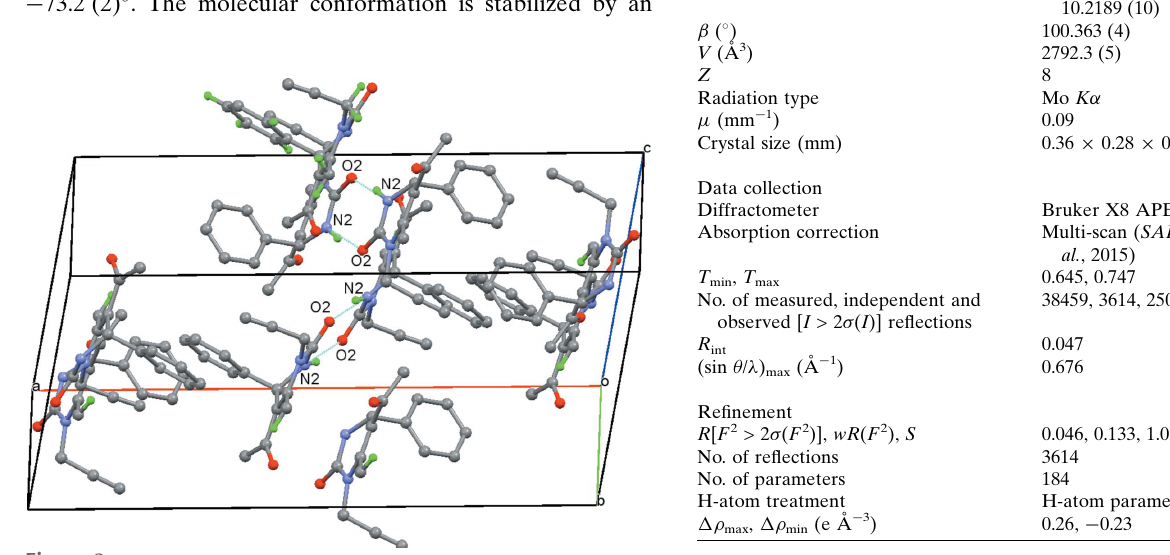
Figure 2 Crystal packing of the title compound, showing molecules linked through N—H (cid:4)(cid:4)(cid:4) O hydrogen bonds (dotted lines).